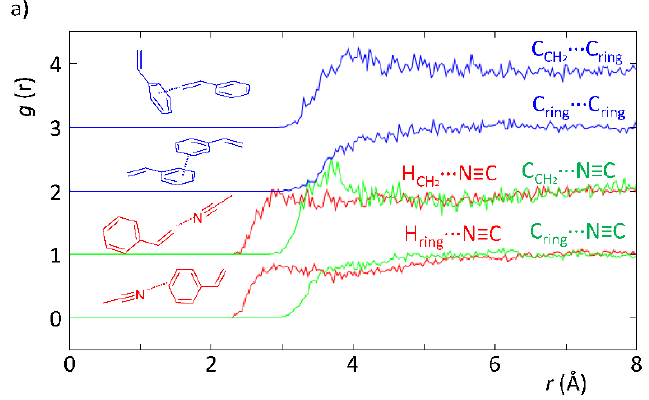
Figure 2. Reaction profiles for R -(+)-limonene oxidation catalyzed by MCM-bpy-Mo catalyst in toluene ( a ) and acetonitrile ( b ) at substrate isoconversion. Reactions were carried out using substrate:oxidant:catalyst mol % ratio of 100:200:3 using acetonitrile or toluene as solvent and at 3535